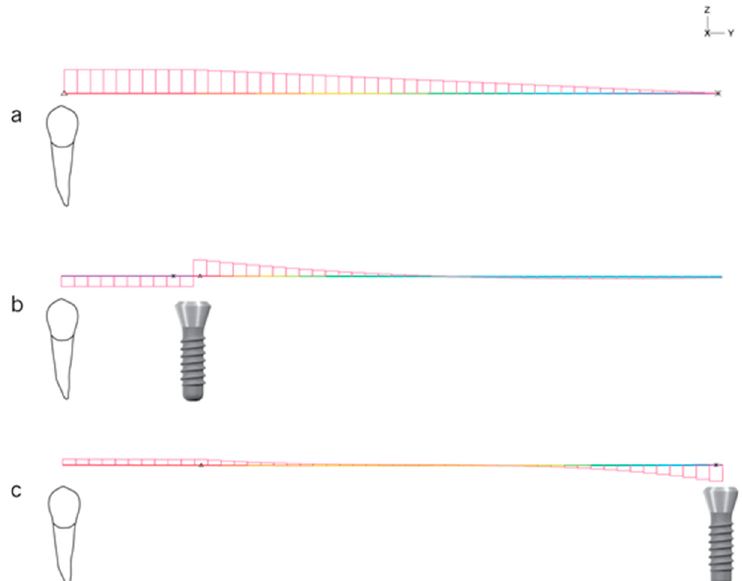
Figure 11. Shear force diagrams for the three simplified models tested: ( a ) CONVENTIONAL RPD; ( b ) IARPD PM; ( c ) IARPD MO. A higher magnitude is observed in the CONVENTIONAL RPD model and throughout the beam in representation of the metallic framework, diminishing with the approximation of the free end, where the shear force is null. A similar behavior is observed for the IARPD PM model from the most rigid retention element, the implant, to the free end at the right portion of the beam. As in a simple supported beam with uniformly distributed load, the shear forces in the IARPD MO model equal the vertical forces of the reaction at the supports, though opposite in the support at the right portion of the beam.